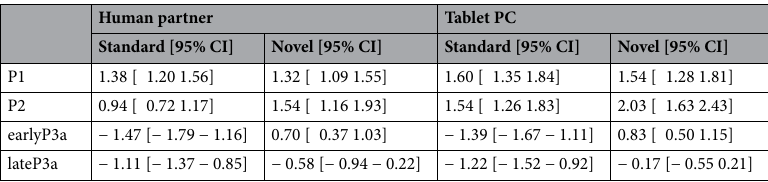
Table 2. Mean component scores of the PCA components.